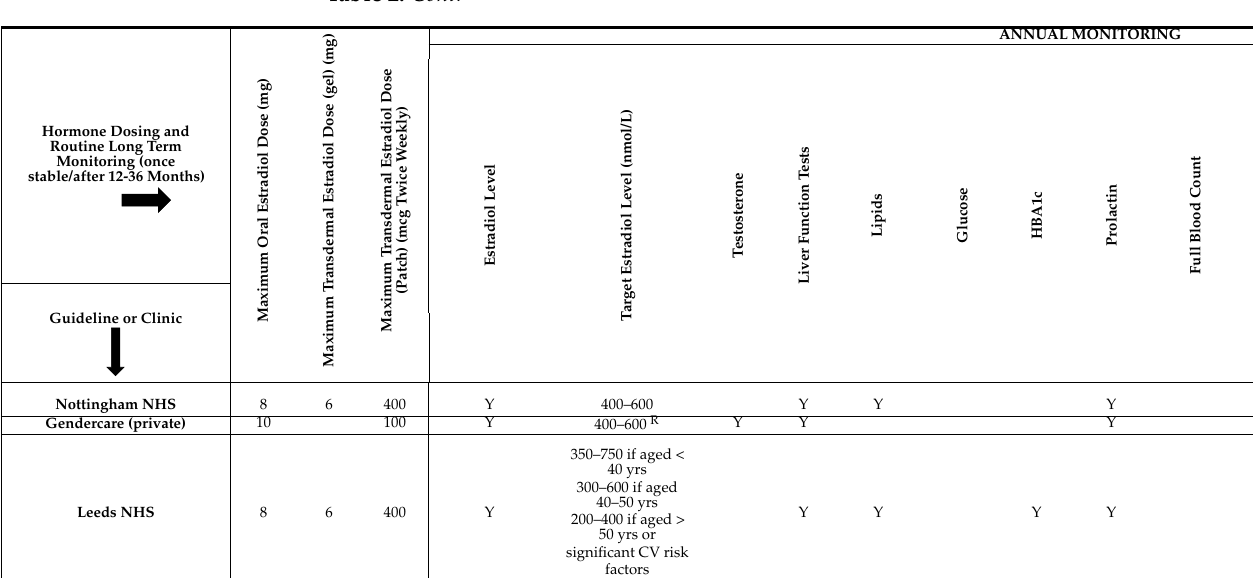
Table 2. Comparison of national, international, and patient specific prescribing and monitoring guidelines for trans women (observed males at birth) with gender dysphoria.